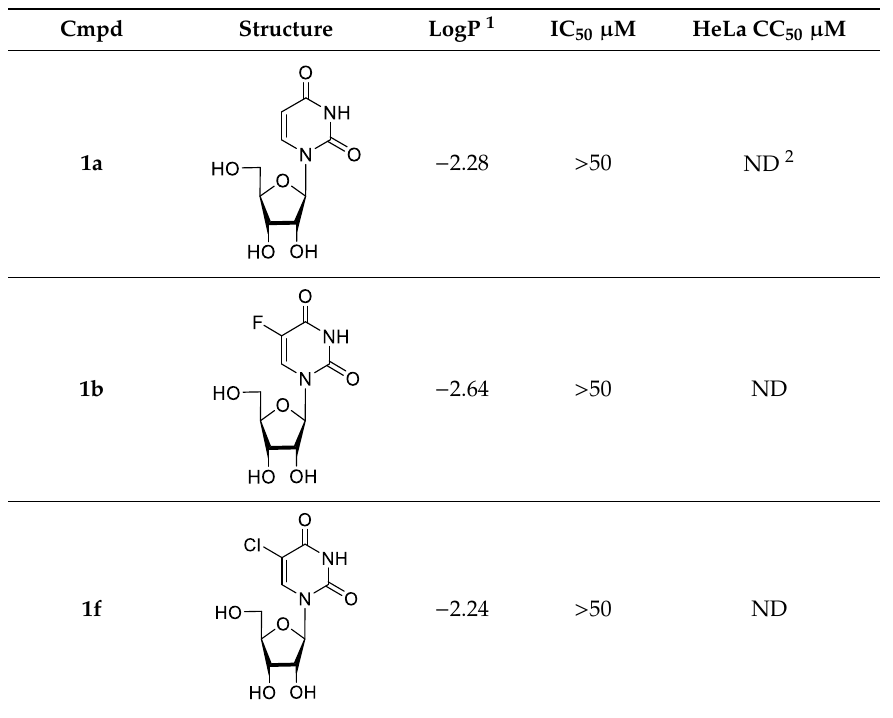
Table 1. Inhibition of Tdp-1 by nucleoside derivatives.